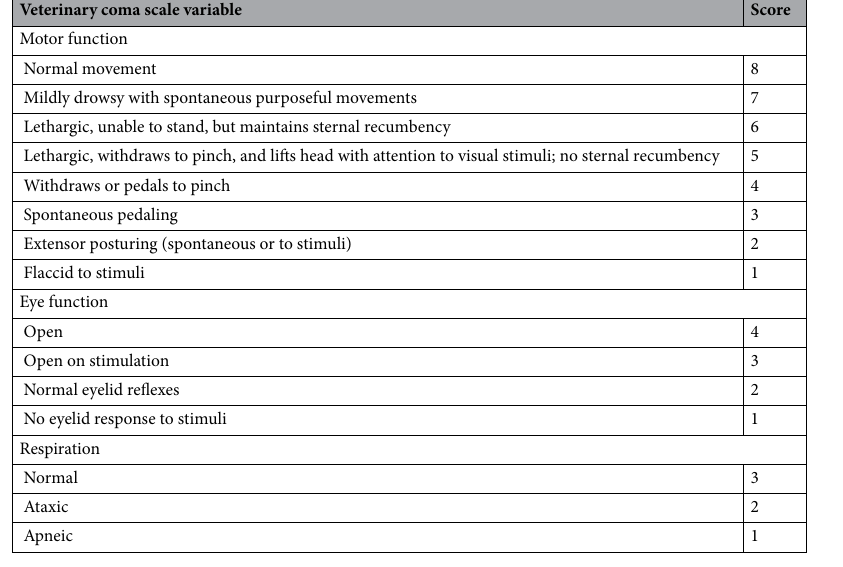
Table 2. Veterinary coma